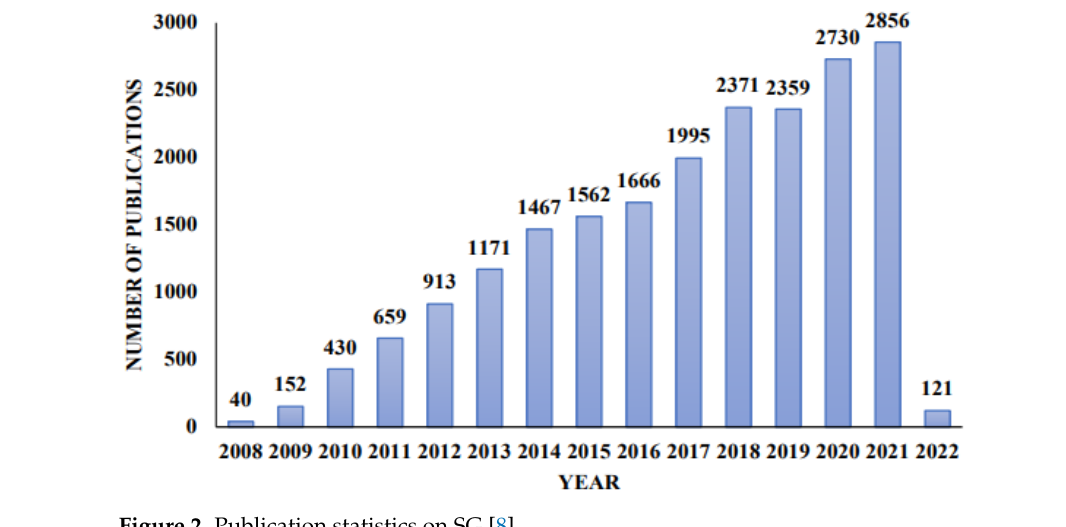
Figure 2. Publication statistics on SG [8]. Table 1. Existing Surveys Related to the Cyber-security of Smart